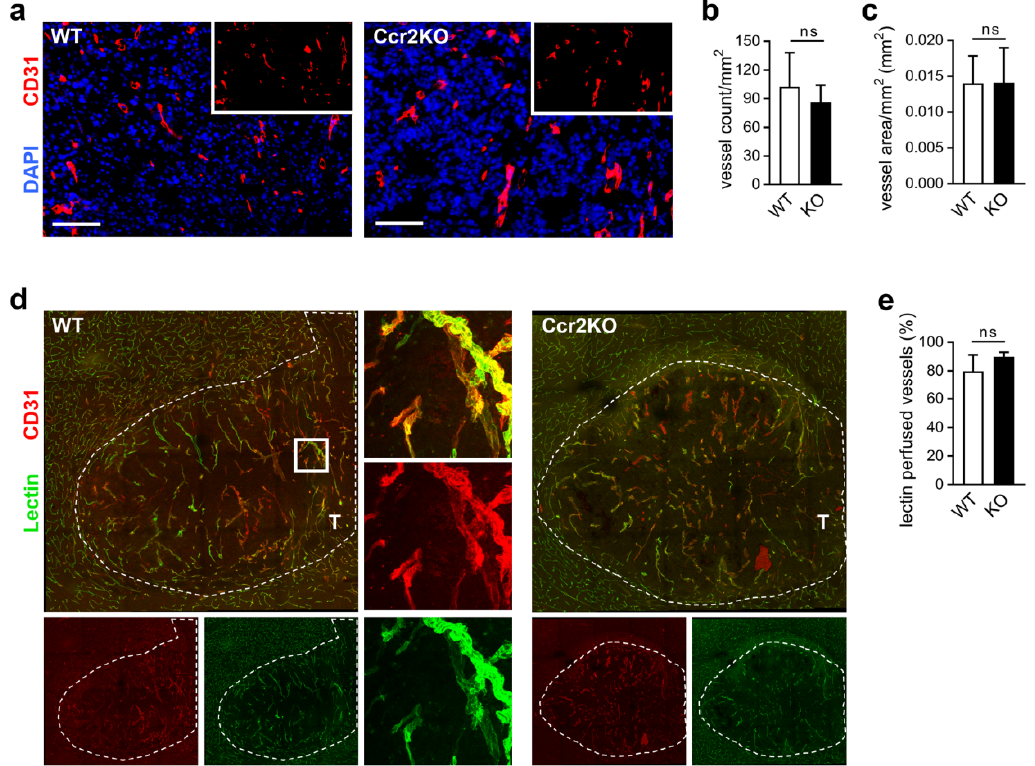
Figure 5. Glioma vasculature is unaffected by Ccr2 -deficiency. ( a ) Representative images of brain tumor sections of WT and Ccr2KO mice stained for CD31 are depicted (d21). Scale bars 100 µ m. ( b,c ) Graphs indicate vessel count (b) and vascularized area (c) within the tumor tissues (n = 6). ( d ) Confocal microscopy of brain tumor sections from mice perfused with FITC-Lectin and stained for CD31 (overview, mosaic). Square indicates the magnified region (63 × ). T , tumor tissue; dashed line , tumor border. ( e ) The graph presents the percentage of perfused vessels (n = 3–4). ns, not significant (unpaired Student’s t -test).